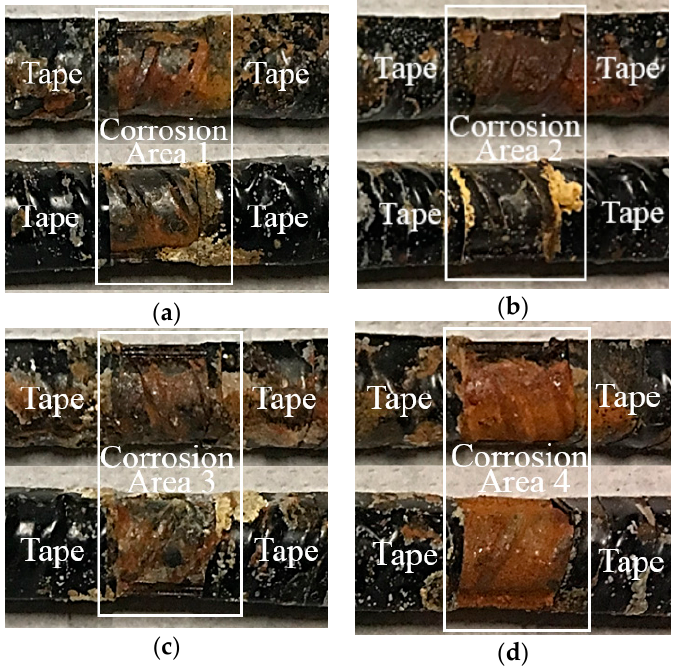
Figure 7. The photo assessment of the four corrosion locations with different corrosion rates. ( a ), ( b ), ( c ), ( d ) Represents the corrosion at area 1, 2, 3, 4 respectively.